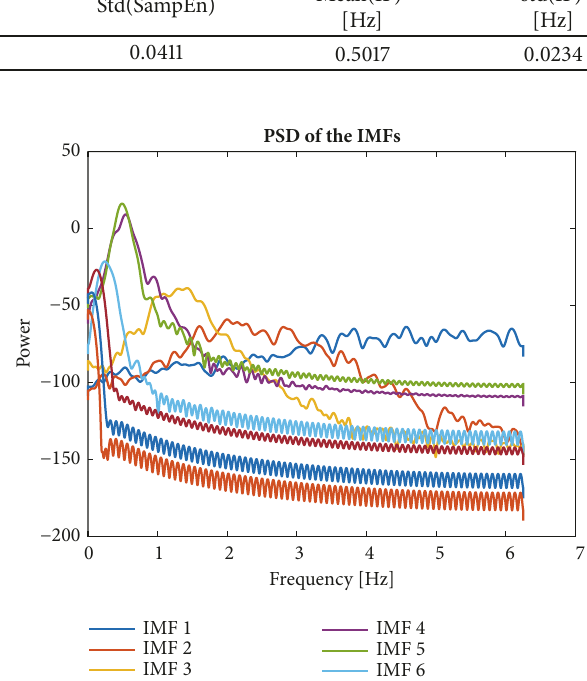
Figure20:PSDestimateofthefirst6IMFsextractedintheanalyzed segment.